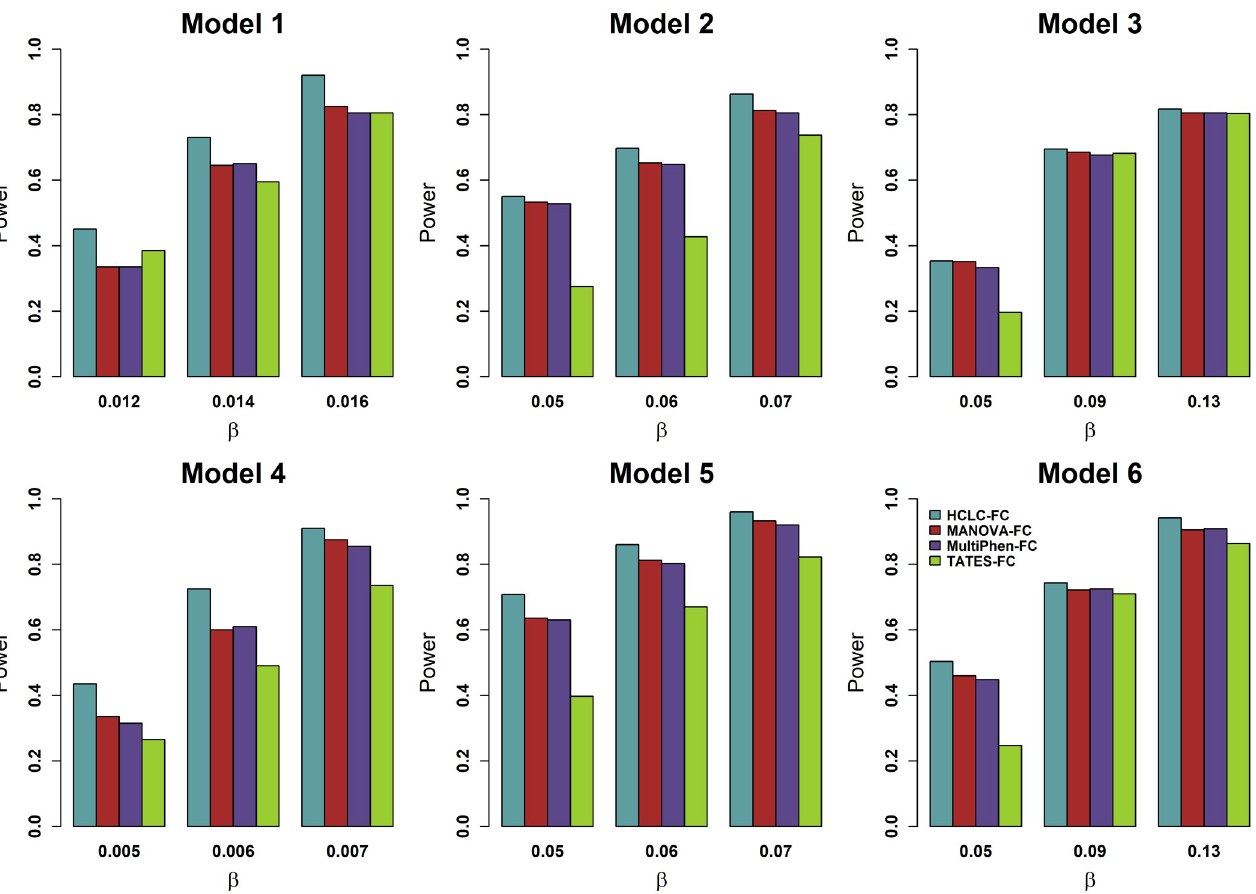
Fig 1. Power comparisons of the four tests for the power as a function of effect size ( β ) under the six models for 1,000 phenotypes ( K = 1,000). MAF is 0.3. The sample size ( n ) is 2,000. ρ f = 0.2, ρ e = 0.3, and c 2 = 0.5. The power of all of the four tests is evaluated using 200 replicated samples at a nominal FDR level of 5%.